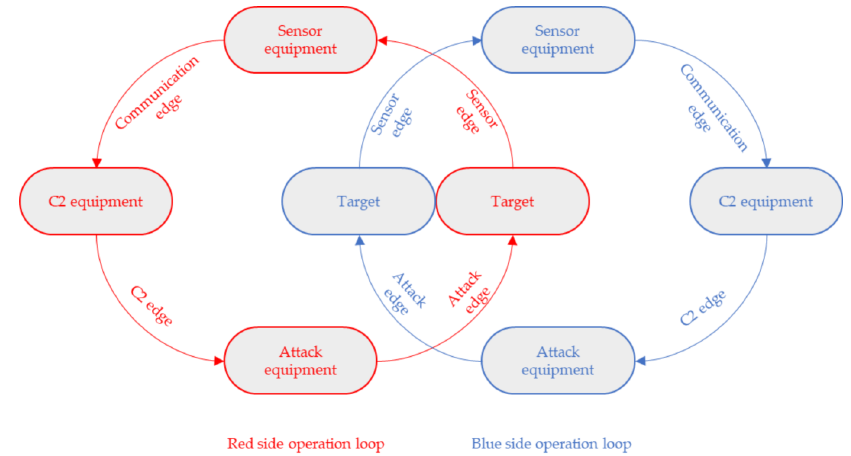
Figure 1. Schematic diagram of the operation loops in the engagement.